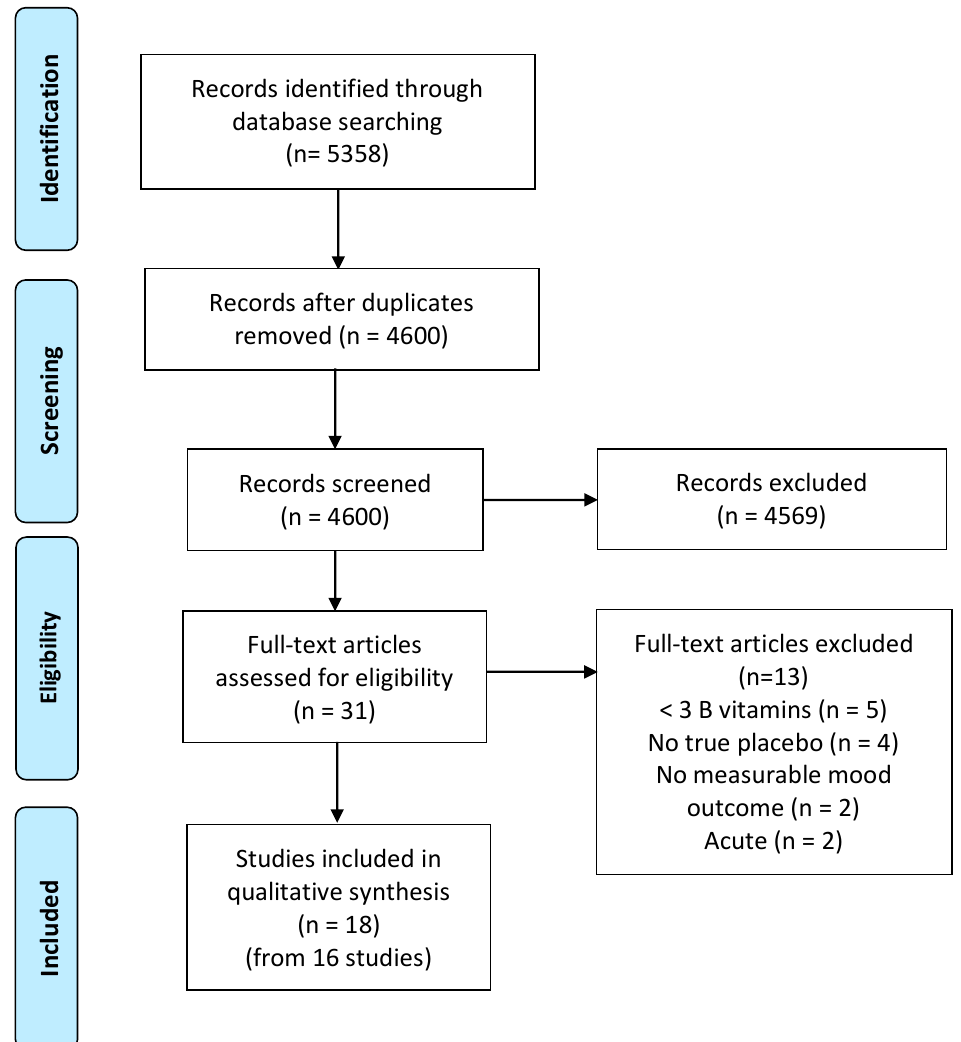
Figure 1. Flow diagram depicting the selection process for articles included in this meta-analysis.